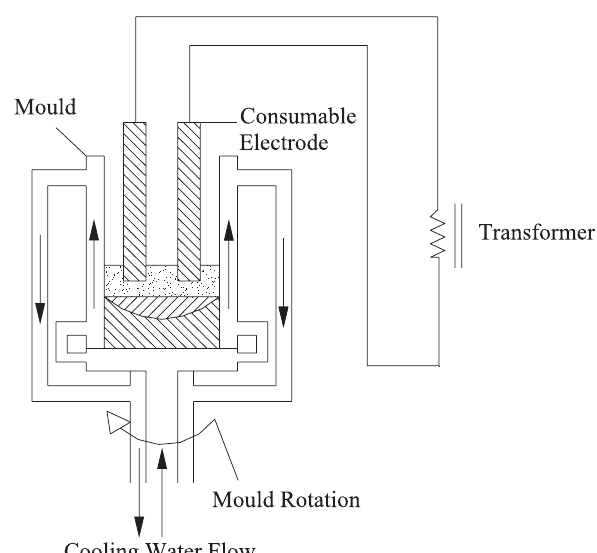
Fig. 1: Schematic of mould rotation ESR furnace.